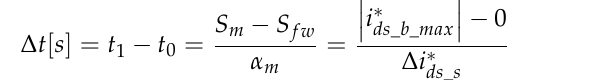
for the design of variable incremental ds